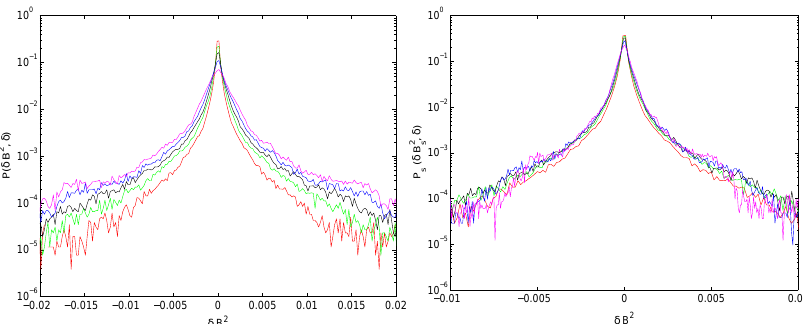
Fig. 1. 2-D MHD simulation results with (512 × 512) grid points for the PDFs of the magnetic field energy density fluctuations δB 2 at scales of δ = 2 (red), 4 (green), 8 (black), 16 (blue) and 32 (magenta) units of grid spacing. Left panel displays the calculated results of P(δB 2 ,δ) and the right panel displays the corresponding scaled distributions for s = 0 . 34.